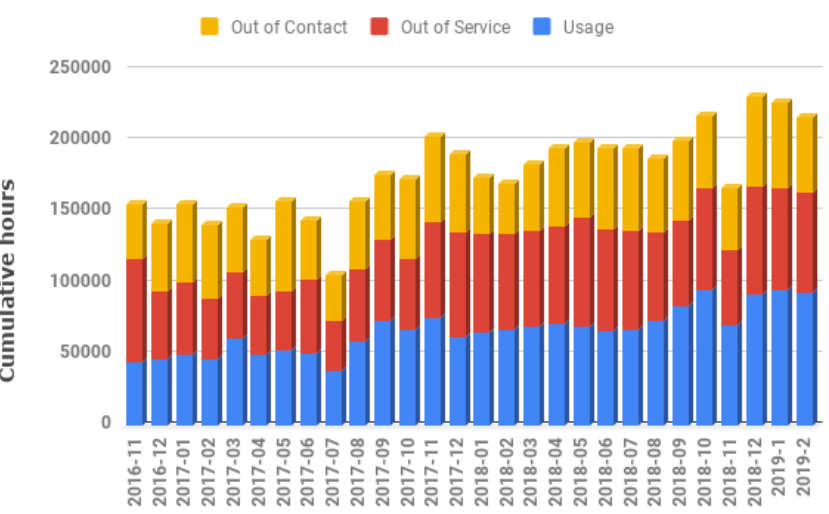
Figure 4. Annual usage/data from the public network in hours.